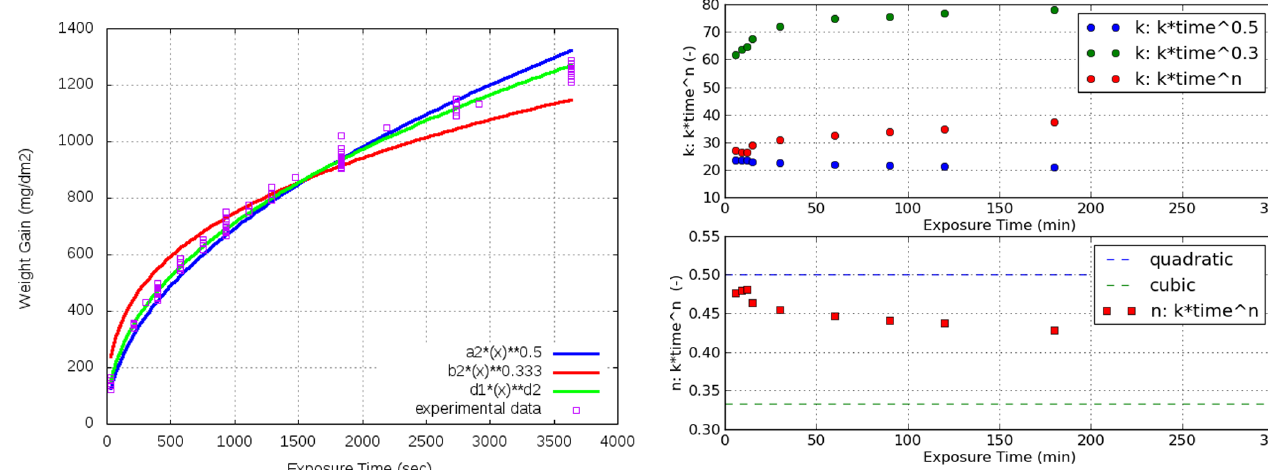
Fig. 1. Optimal oxidation kinetics (quadratic, cubic, and power- law function) for temperature 1050 ° C and maximal exposure time 60 min. Table 1. The chemical composition of the studied materials.